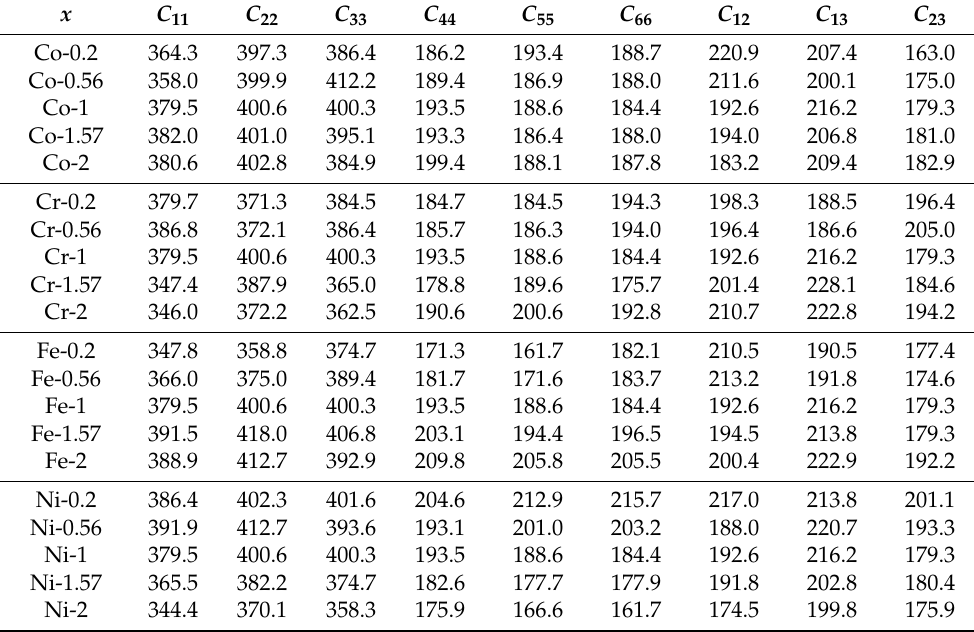
Table 2. Elastic constant C ij of Co-Cr-Fe-Ni HEAs. The unit is GPa.